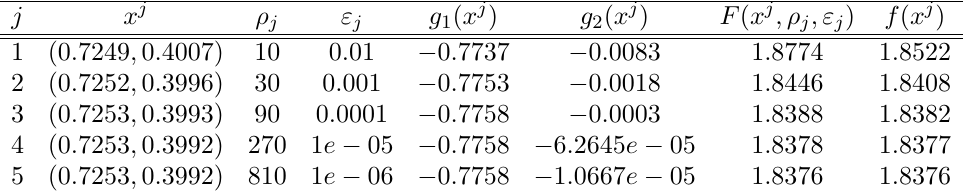
Table 1. Table of minimization process of the Problem 1.